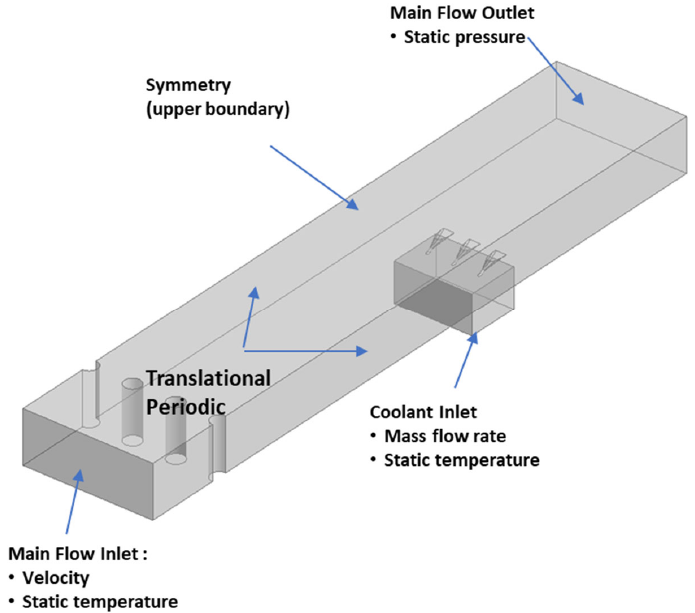
Figure 7. Boundary conditions for the three-dimensional CFD domain including a row of circular cylinders and fan-shaped film cooling holes.